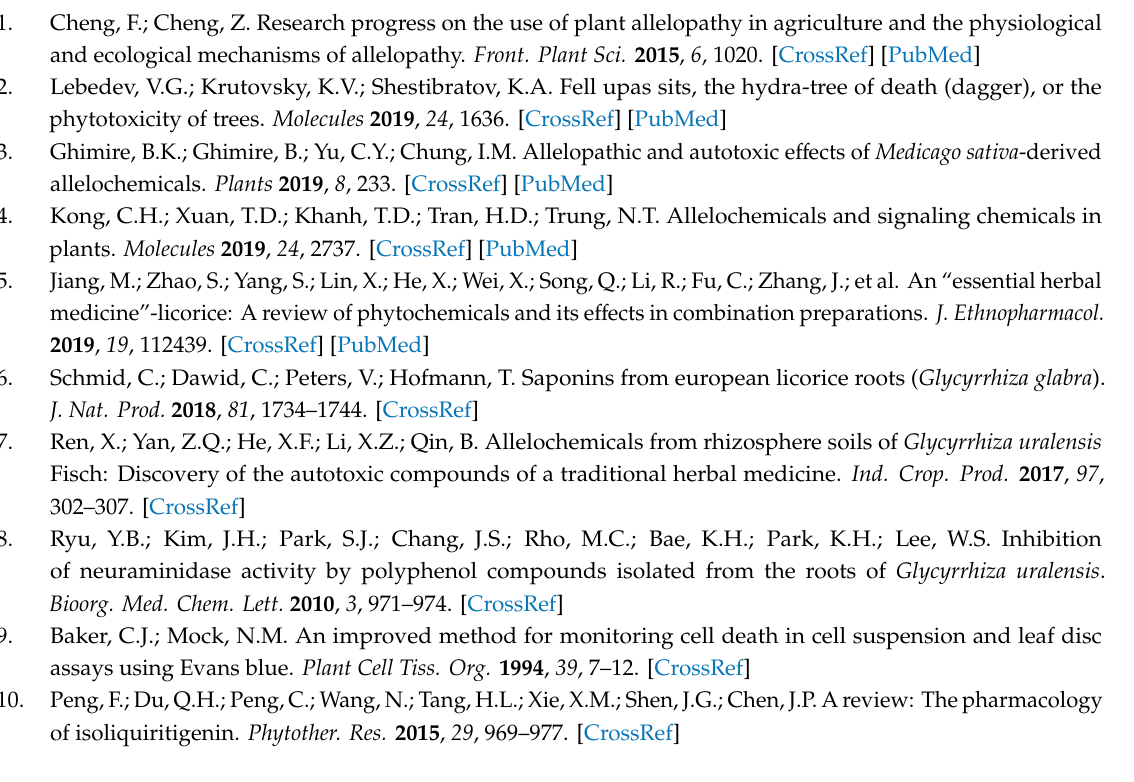
Figure S1: 1 H NMR spectrum of isoliquiritigenin, Figure S2: 13 C NMR spectrum of